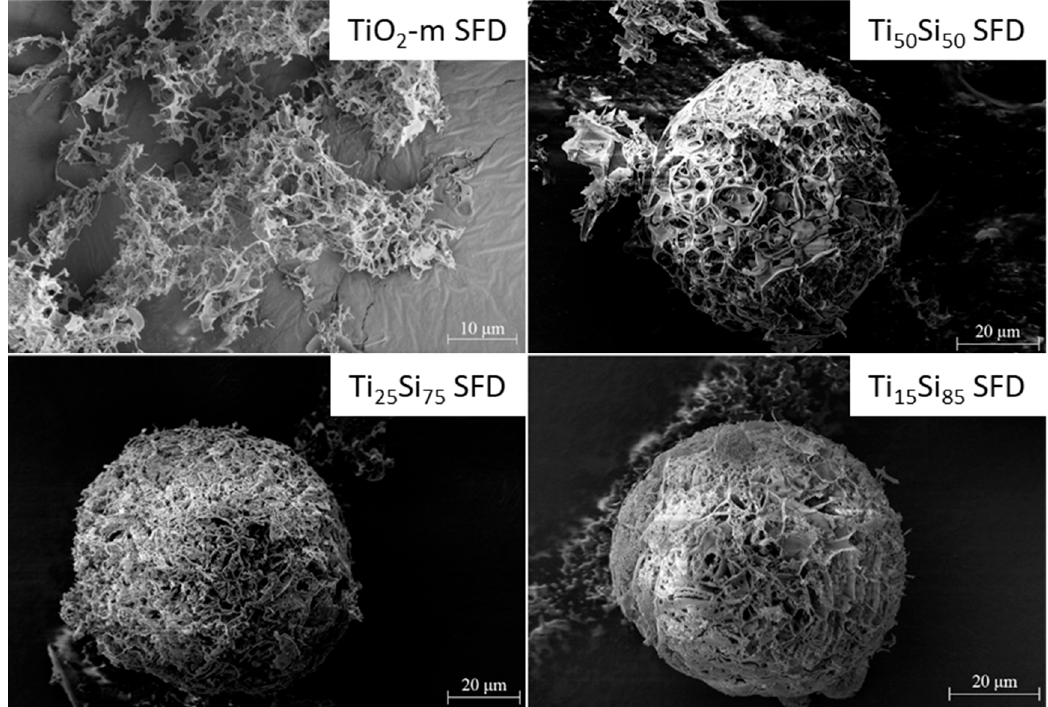
Figure 2. SEM images of the spray-freeze dried powders.